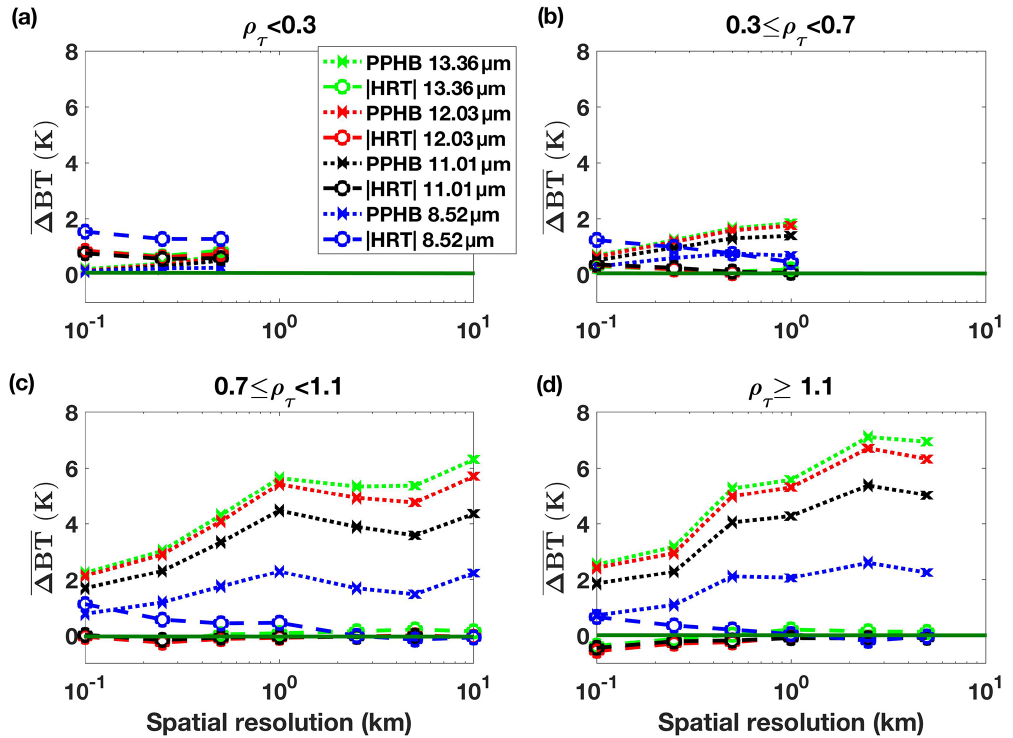
Figure 10. Scene-average, plane-parallel and homogeneous bias (PPHB) and mean deviation due to the horizontal radiative transport ( | HRT | ) effect on brightness temperatures ( (cid:49) BT) for (a) small, (b) medium, (c) large and (d) very large pixel inhomogeneity ( ρ τ ) as a function of spatial resolution in channels centered at 8.52, 11.01, 12.03 and 13 . 36µm. The small optical thickness range corresponds to 8969 pixels, the 2724 medium pixels, the 347 large pixels and the 89 very large